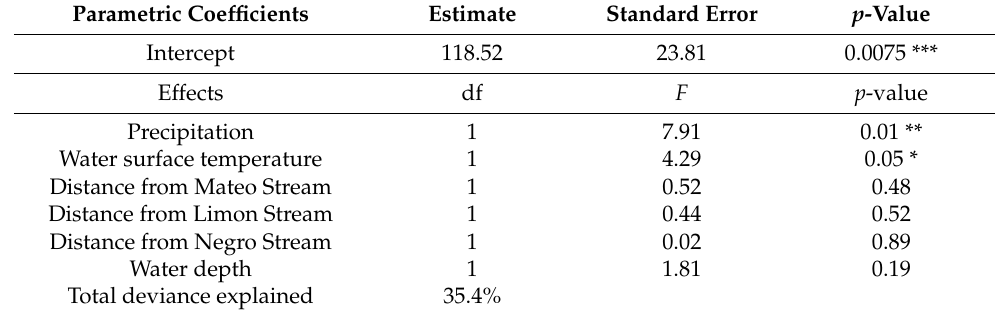
Table 2. Effects estimated by the Generalized Additive Model of the density of microplastics in surface water in the Luruaco Lake, p -value: *** (<0.01), ** (<0.05), * (<0.1).